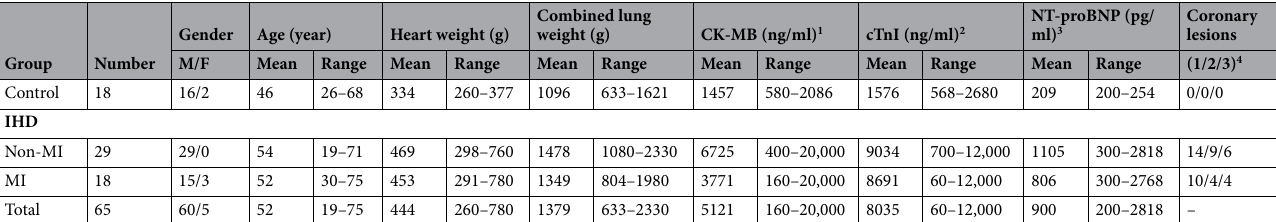
Table 1. Case profiles. 1 –3 Reference value of each indicator: cTn I 181–3352 ng/ml; CK-MB 340–2420